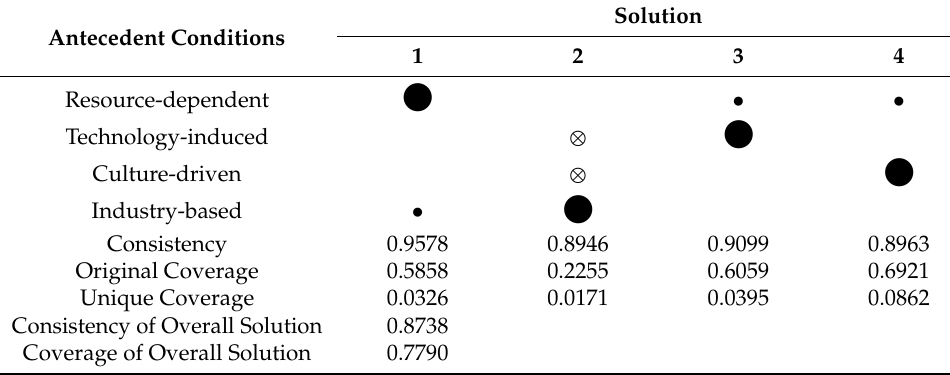
Table 4. Configurations of conditions for establishing a strong brand effect. Antecedent Conditions